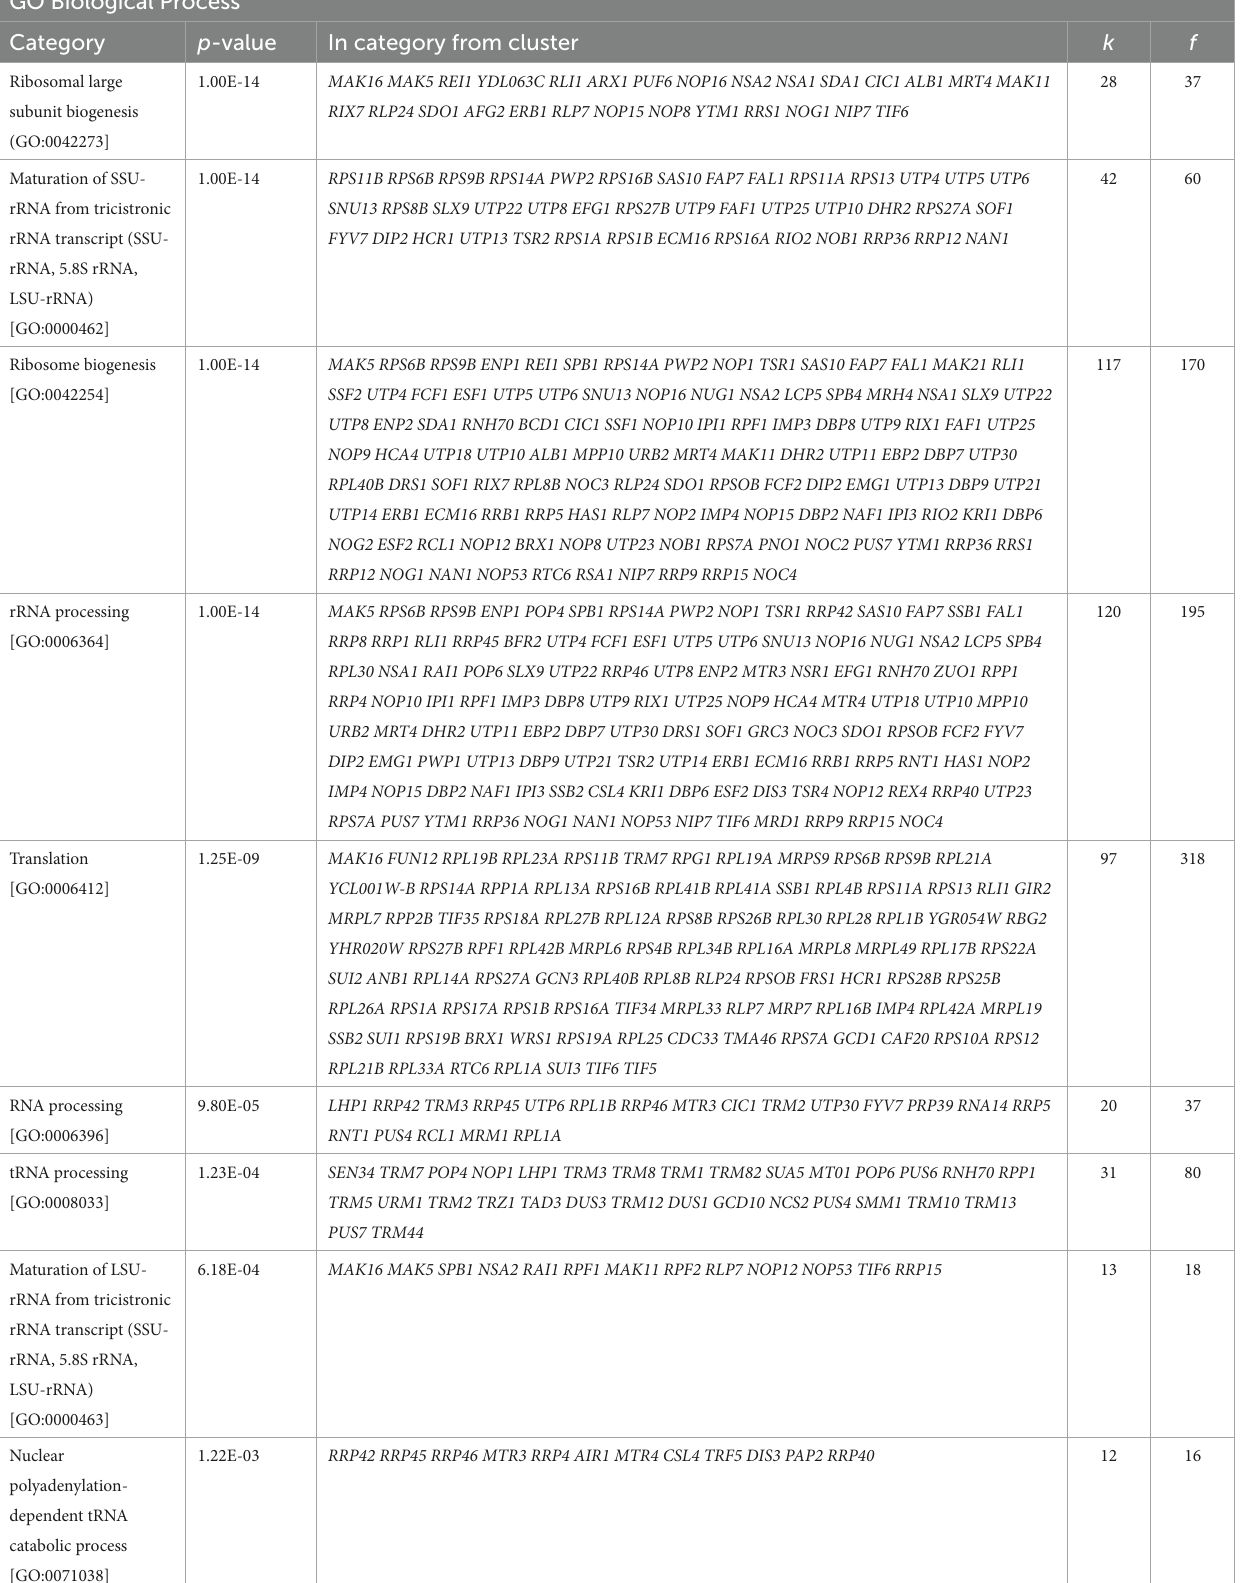
TABLE 3 FUNSpec Gene Ontology (GO) analysis results of the downregulated genes in C9. GO Biological